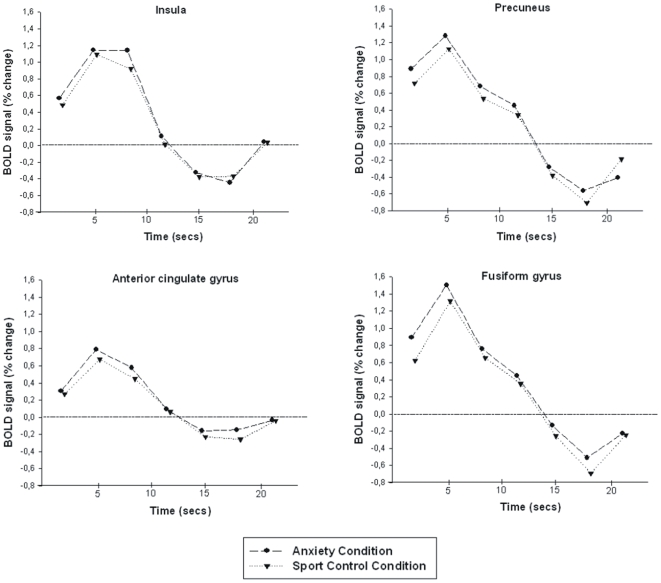
Time course of mean activations with respect to the anxiety and the sport control condition across all trials and participants [insula (x = 45 y = 12 z = 0), precuneus (x = 3 y = −54 z = 57), anterior cingulate gyrus (x = 6 y = 21 z = 21), fusiformis gyrus (x = −45 y = −60 z = −21)].